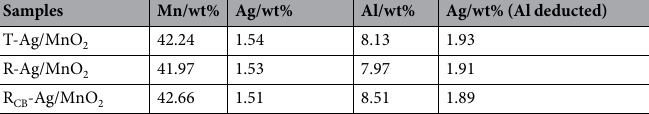
Table 2. Catalysts element components.